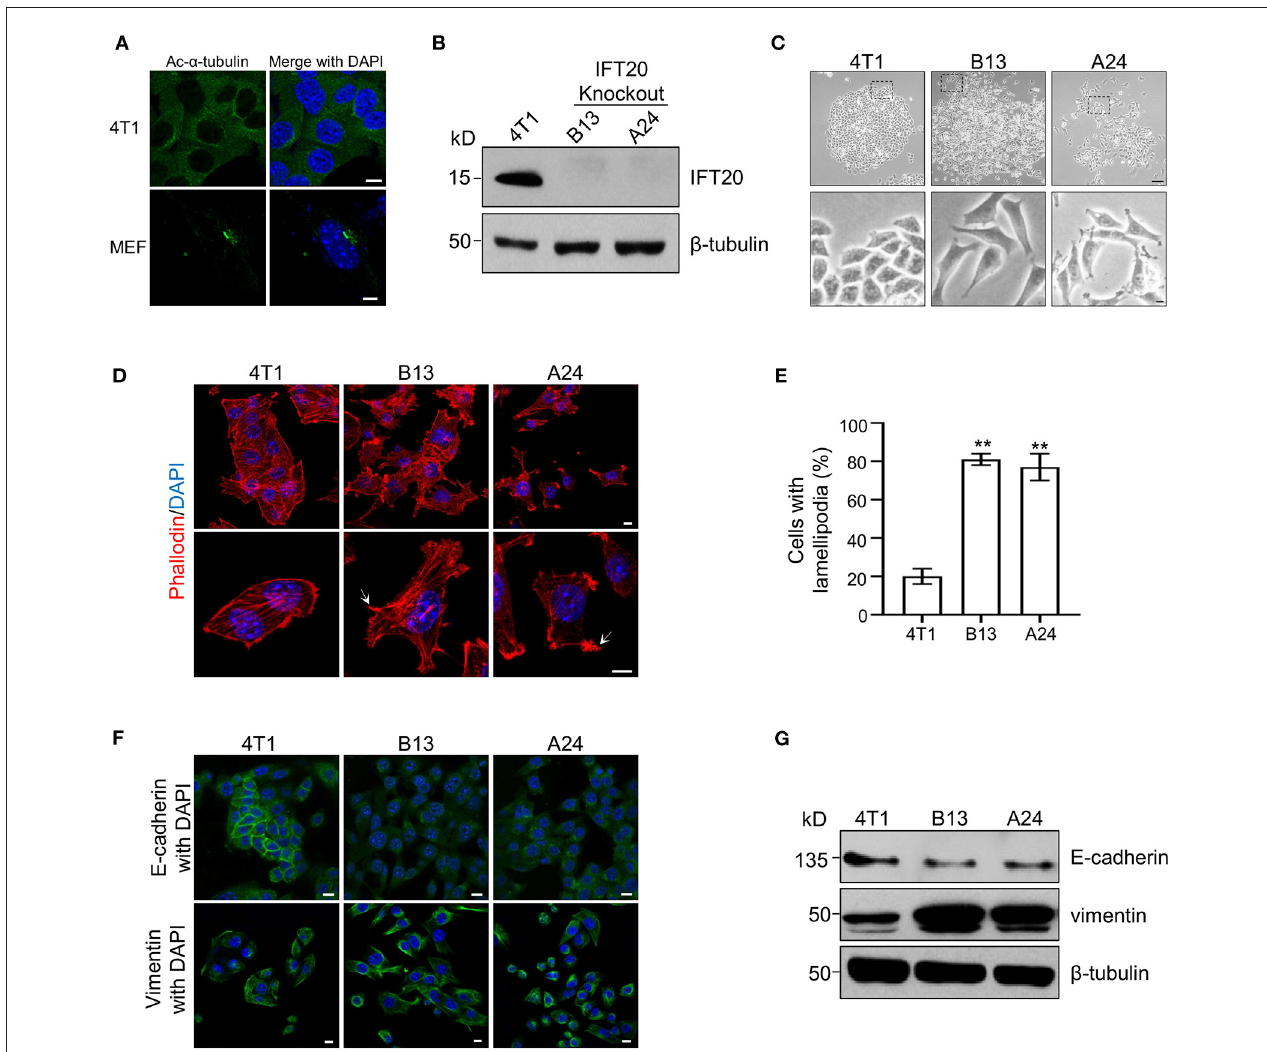
FIGURE 2 | Loss of IFT20 in mouse breast cancer cells 4T1 induces lamellipodia formation and epithelial mesenchymal transitions (EMTs). (A) Representative immunostaining of 4T1 and mouse embryo fibroblast (MEF) cells with Ac- α -tubulin antibodies showed that no cilia were formed in 4T1 cells, unlike cilia-positive MEF cells, when treated with serum starvation for 36h. (B) Western blots of cell lysates from 4T1 and IFT20-knockout mutants (B13 and A24) probed with IFT20 antibodies. (C) Phase-contrast photographs of 4T1 and IFT20-KO cells showed that loss of IFT20 resulted in cell morphology changes from a cobblestone appearance into spindle-like shapes. The lower panels showed the higher magnification photographs of the insets in the top panels, respectively. (D) Representative fluorescent images of F-actin stained with rhodamine B-conjugated phalloidin showed that the loss of IFT20 induced the formation of more lamellipodia. The white arrows indicate the lamellipodia. The nucleus is stained by DAPI. (E) Quantification of the cells with lamellipodia in 30 randomly selected cells in each group of (D) . Results are representative of three independent experiments. (F) Representative immunostaining images of 4T1 and IFT20-KO cells stained with the epithelial marker (E-cadherin) and mesenchymal marker (vimentin) showed that the loss of IFT20 induced EMTs. (G) Western blots of cell lysates from 4T1 and IFT20-KO cells probed with epithelial and mesenchymal markers showed that the loss of IFT20 resulted in the down-regulation of E-cadherin but the up-regulation of vimentin. β -tubulin was used as the loading control. All immunostaining experiments were performed three times. The nucleus is stained by DAPI (blue). Scale bar, 5 µ m (A) ; 50 µ m ( C top panel); 10 µ m ( C lower panel, D,F ). Error bars represent standard deviations. The p -values indicated were calculated by Student’s t -tests (unpaired). n.s. (not significant) p > 0.05; * p ≤ 0.05; ** p ≤ 0.01.